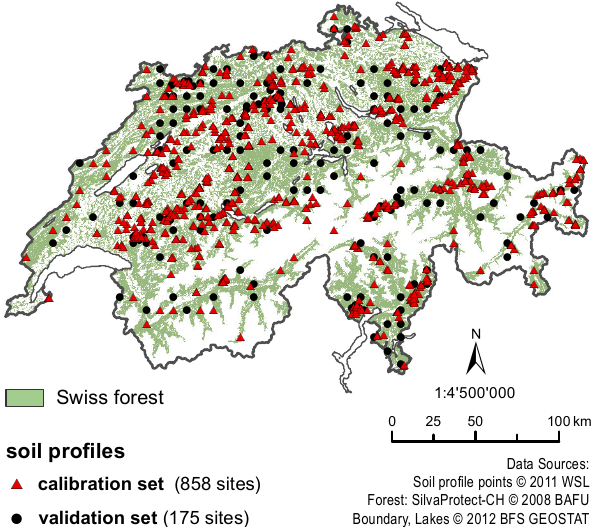
Figure 2. Locations of the 1033 soil profiles and Swiss forest area (subdivided into calibration and validation